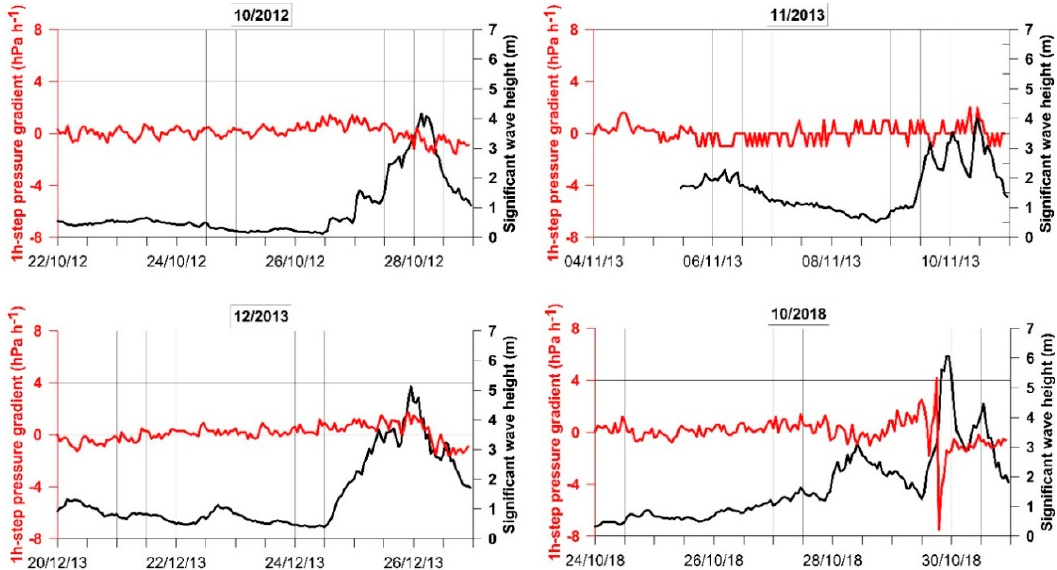
Figure 6. Significant wave height (m, black lines) superimposed on the temporal variation of the baric gradient (hPa, red lines) for hourly time window for a period of seven days around the sea storms of October 2012, November and December 2013, and October 2018.